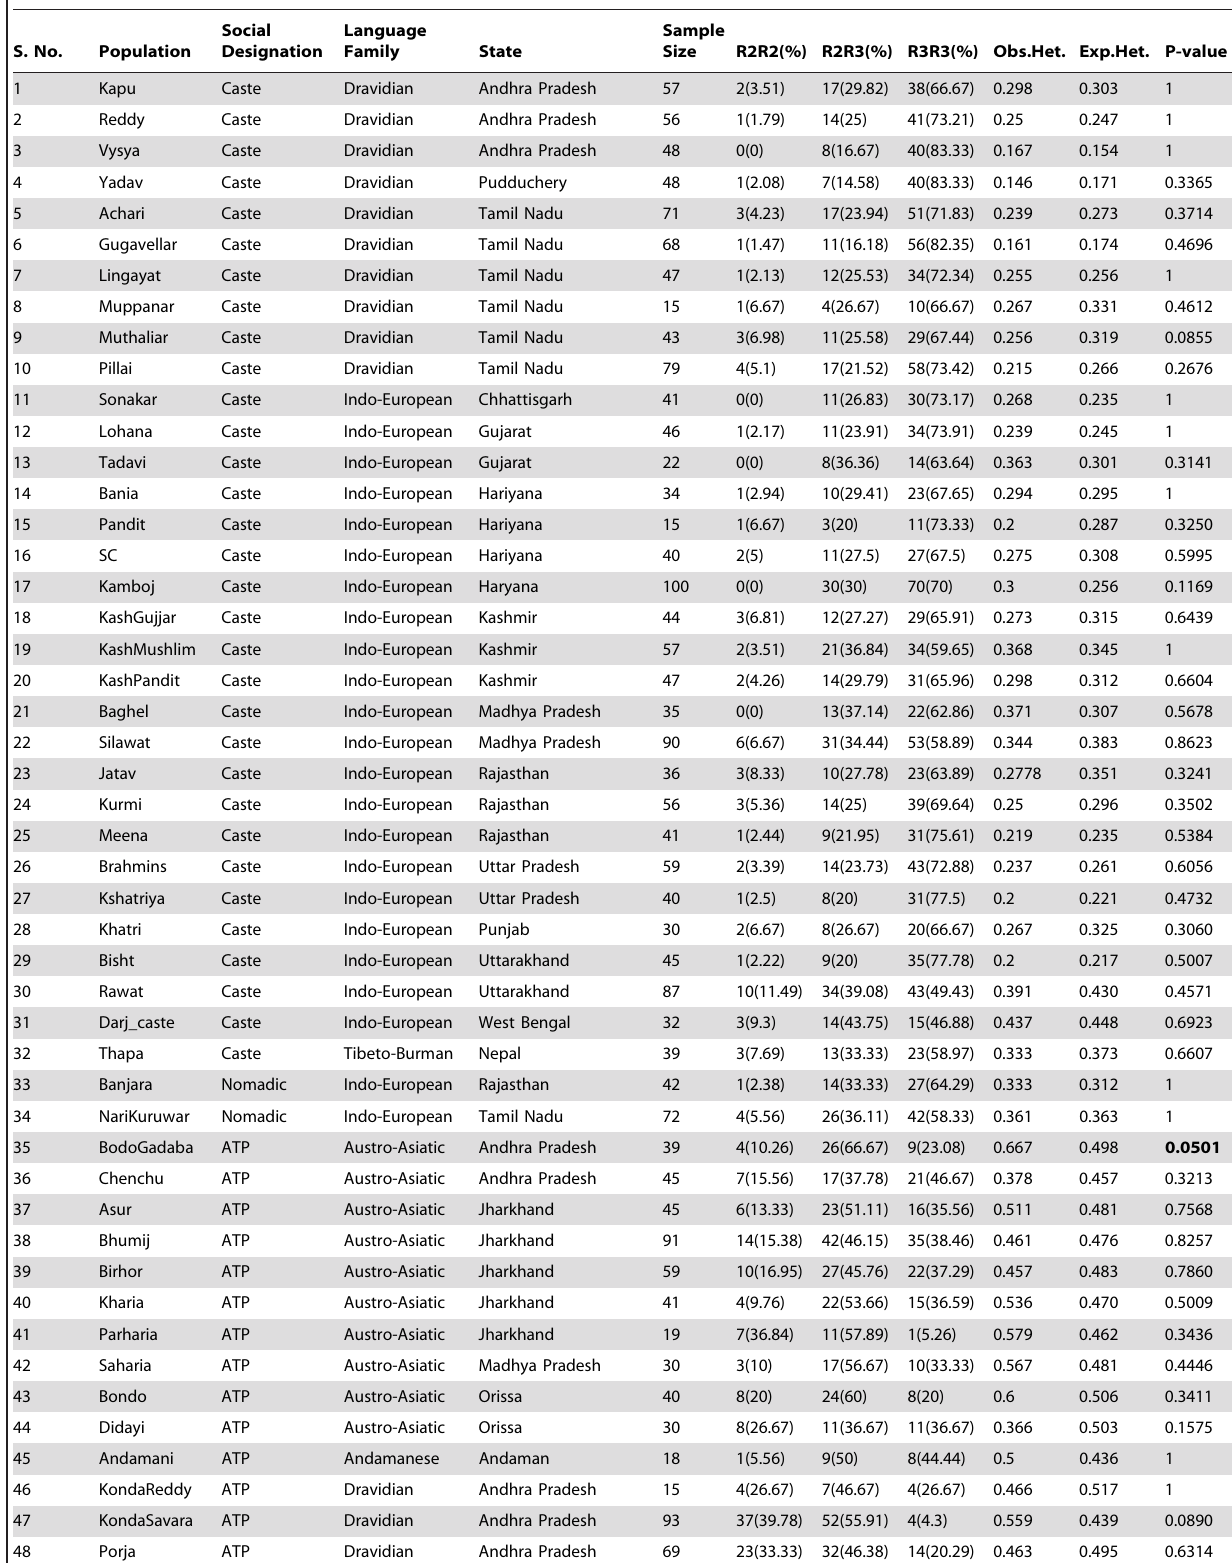
Table 5. Social status, geographical origin, ethnicity, linguistic affiliation and HW equilibrium of Indian populations included in present